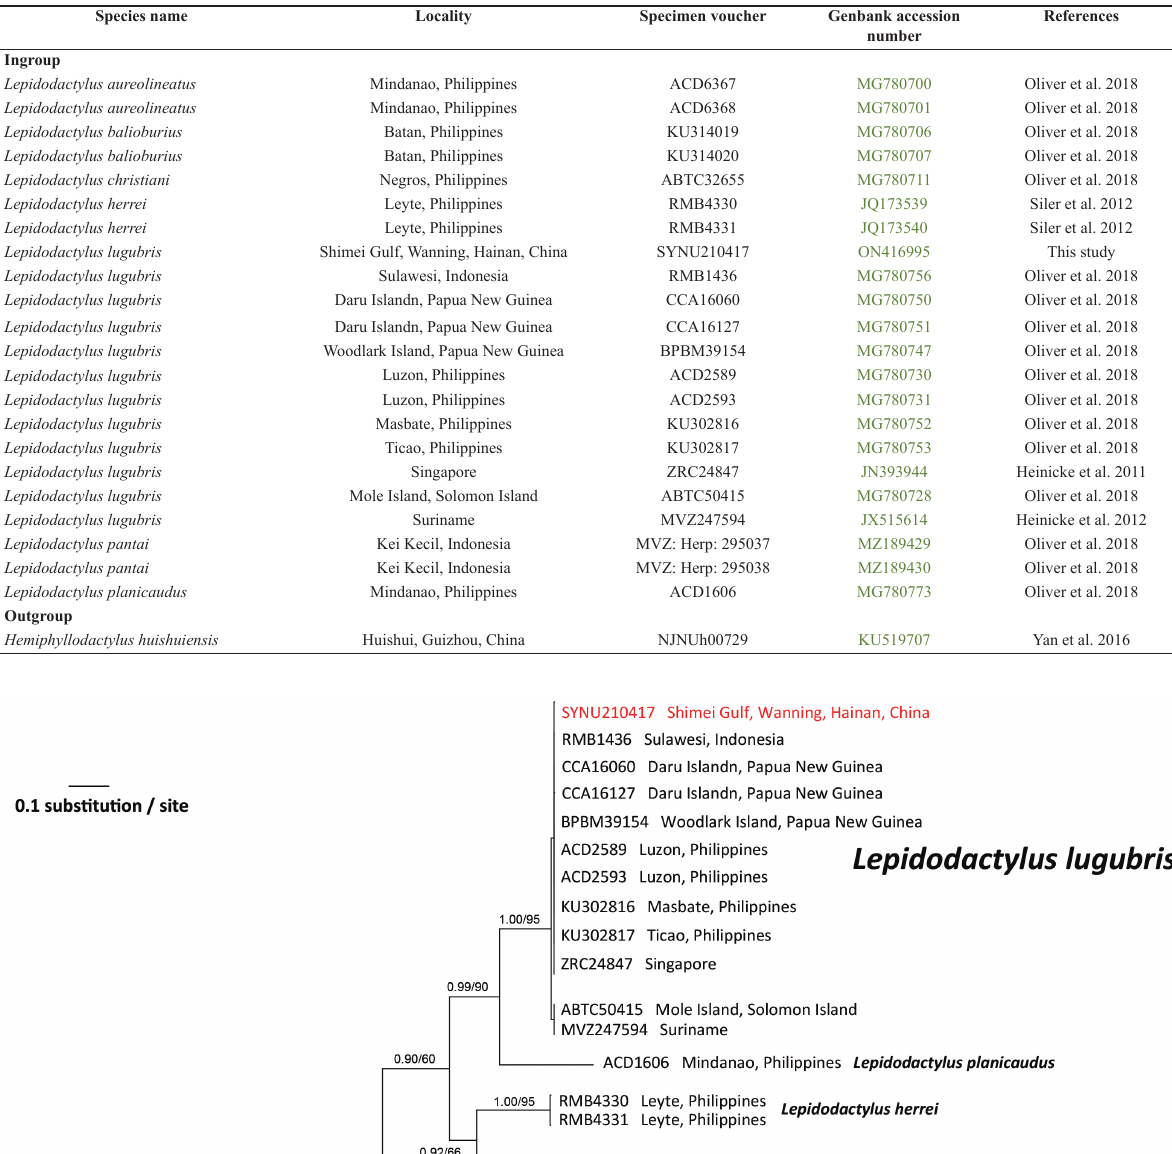
Table 1. Localities, voucher information, and Genbank accession numbers for all specimens used in this study.